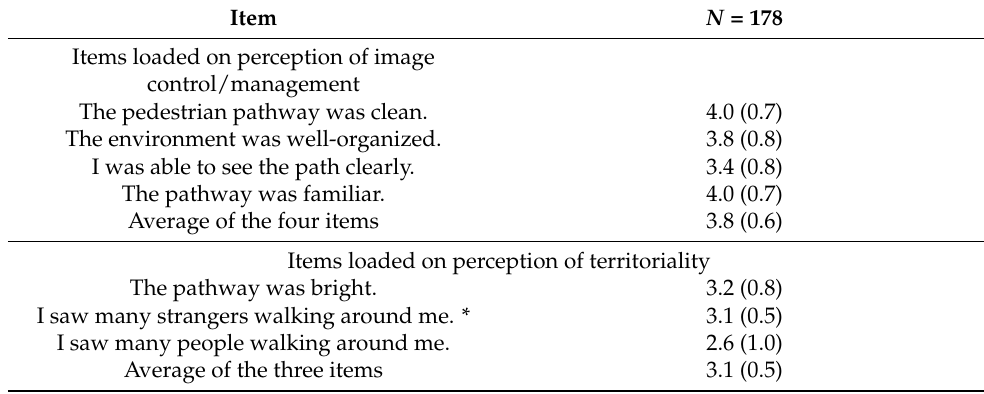
Table 5. Participants’ perceptions of the pedestrian pathways on campus that they walked at night.